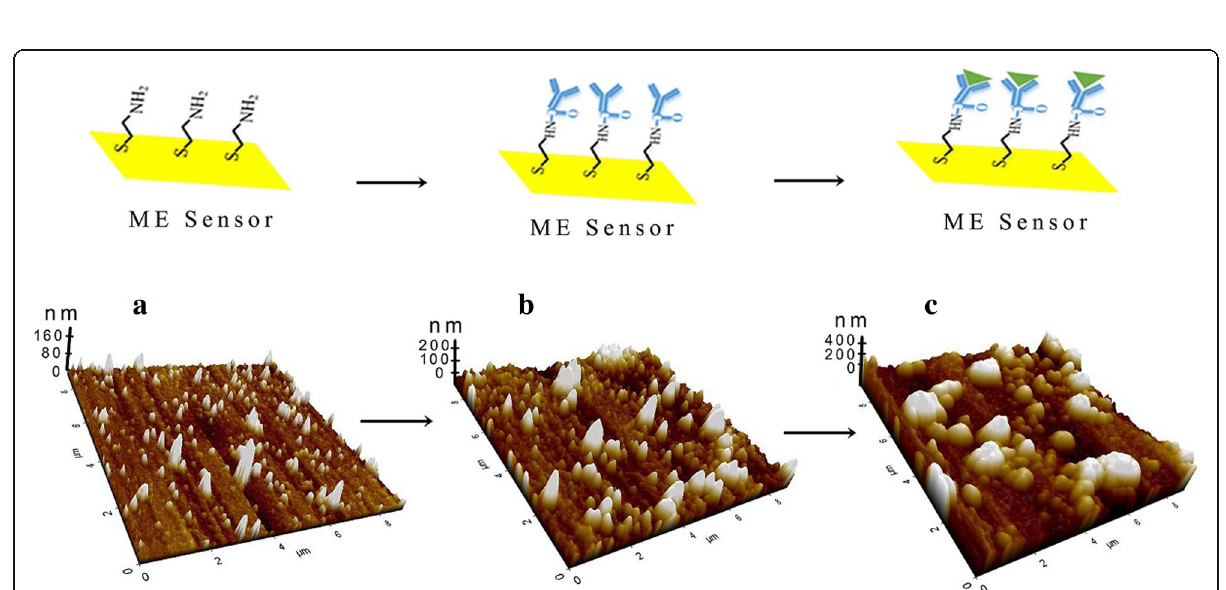
Fig. 3 AFM images of SAM layer ( a ). CEAAb-SAM layer ( b ). Complex of CEA-CEAAb( c